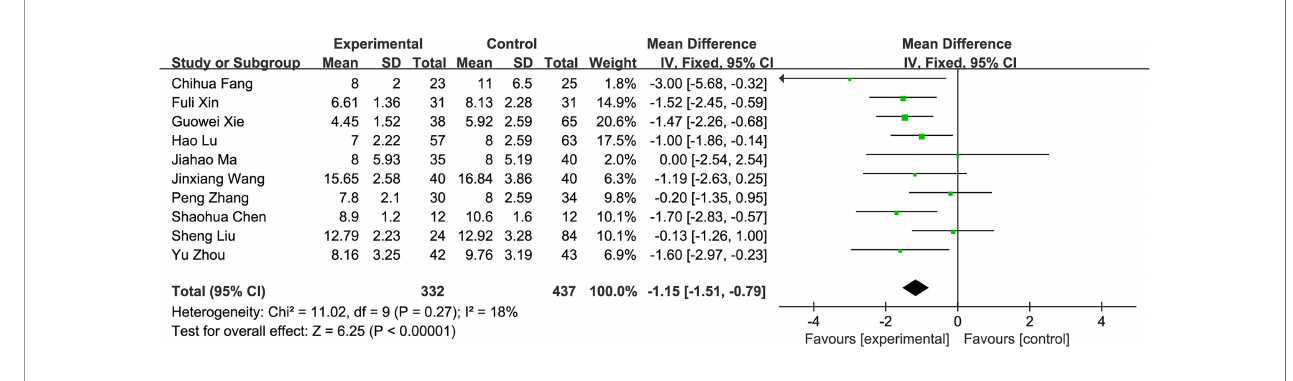
FIGURE 6 | Postoperative hospital stay.